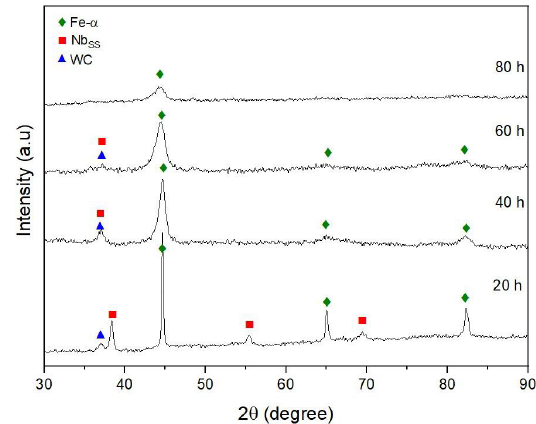
Figure 16. Fe-15at.%Nb sample diffractogram after milling with stearic acid PCA.